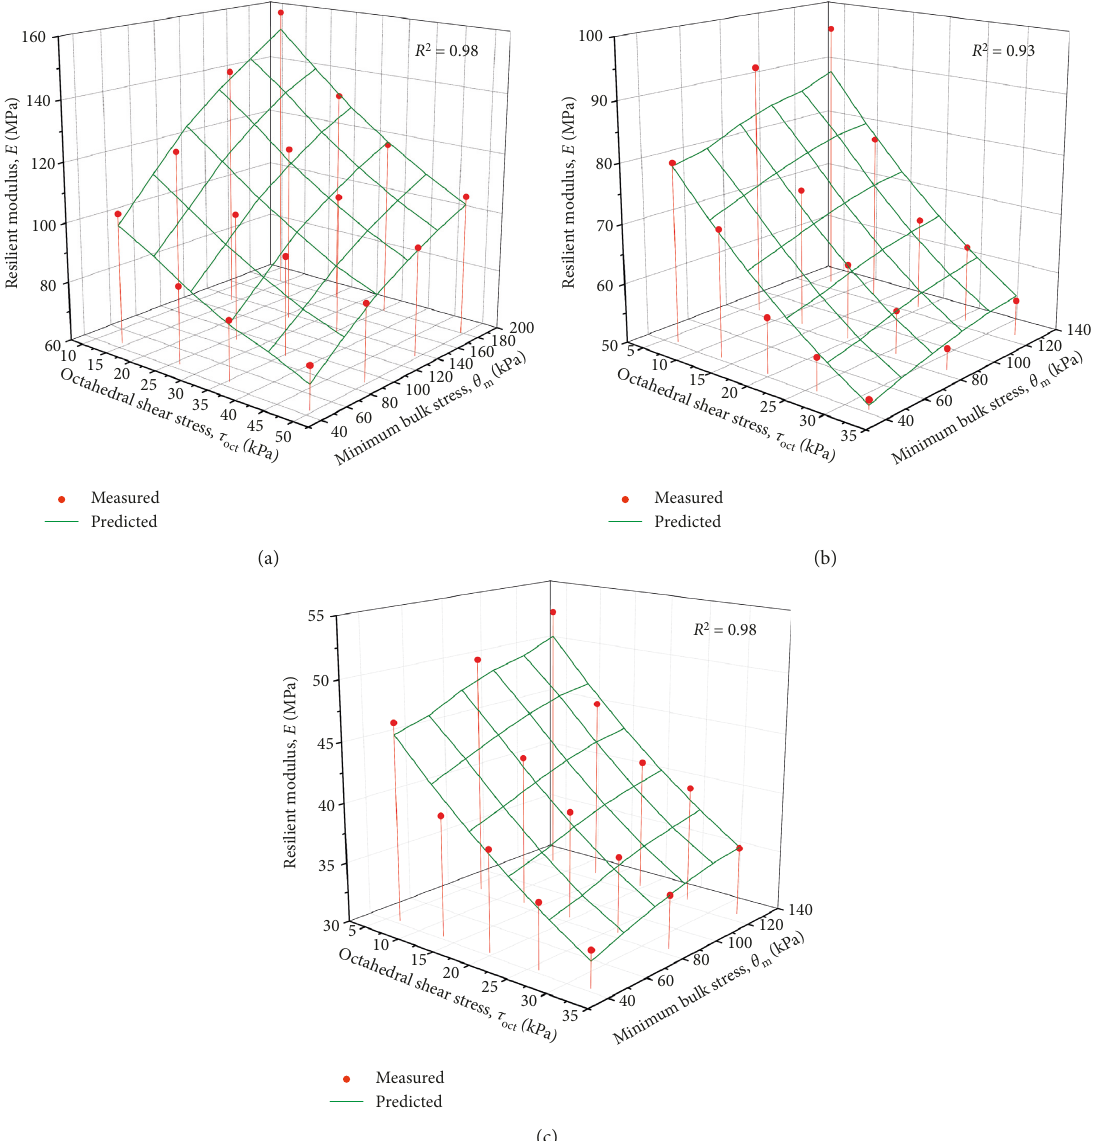
(c) F IGURE 2: Comparison of predicted and measured Mr for different soils: (a) low plasticity clay (from Guangdong, China); (b) low plasticity clay (A-4 from the United States [28]); and (c) low plasticity clay (A-6 from the United States